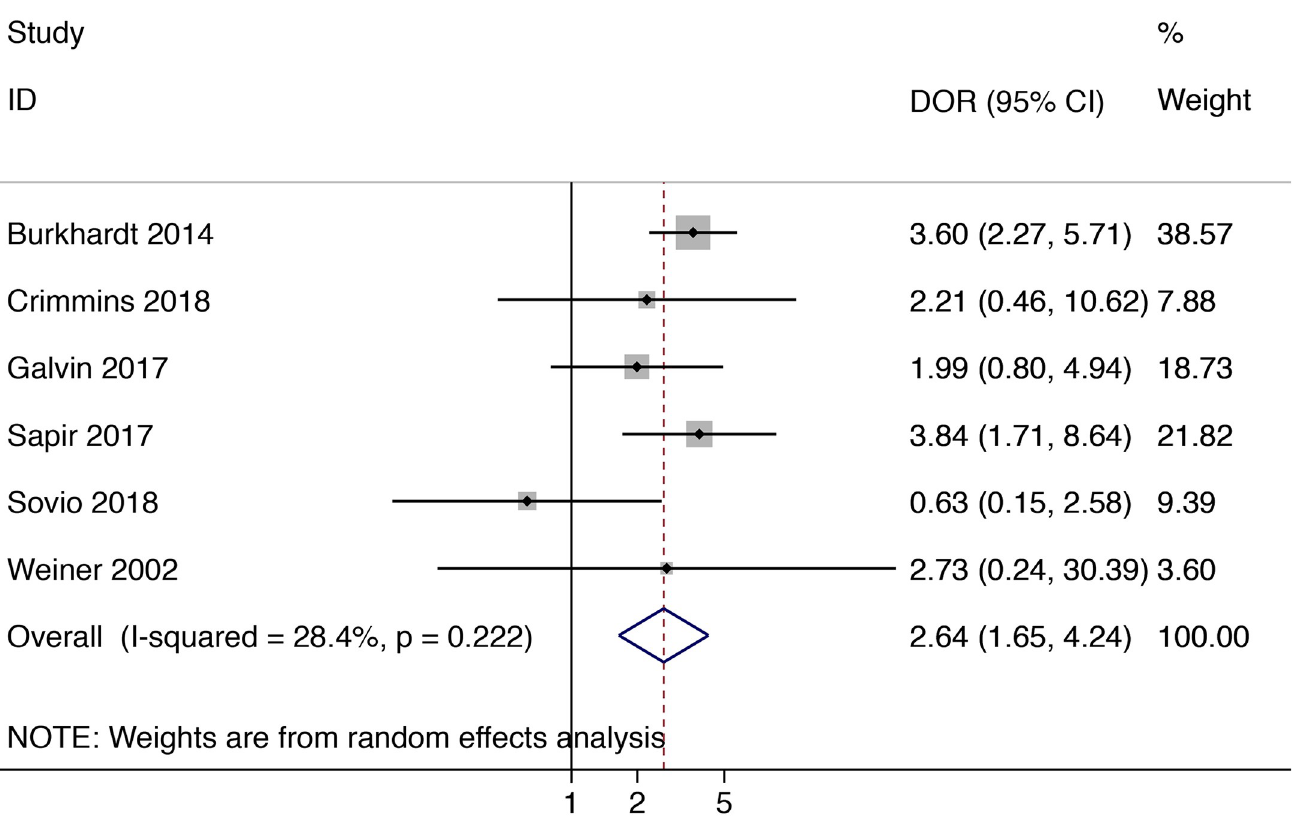
Fig 5. Diagnostic performance of EFW > 4,000 g (or 90th centile) at predicting shoulder dystocia. EFW, estimated fetal weight.